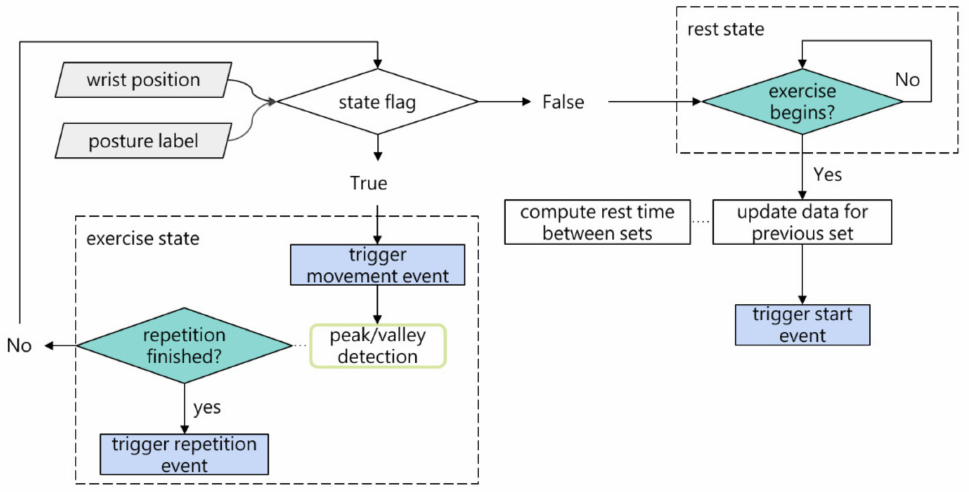
Figure 6. Flowchart of state analysis.